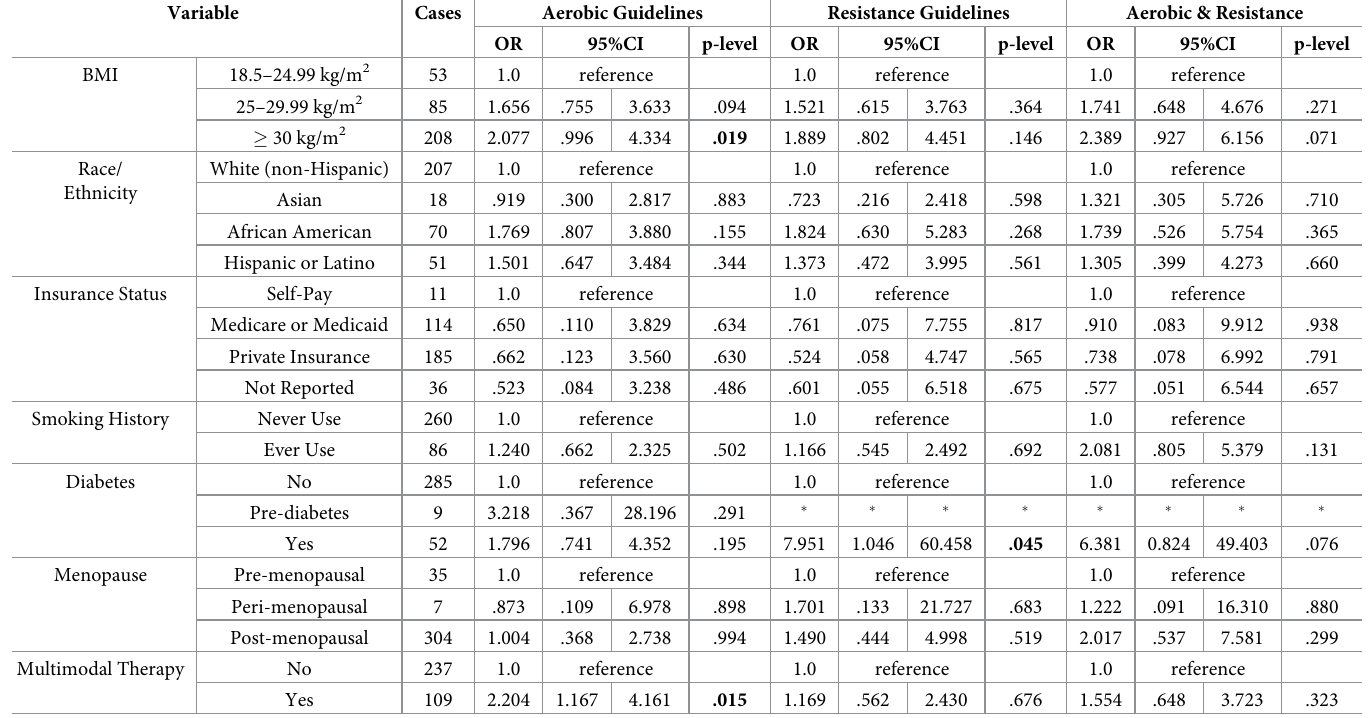
Table 3. Factors associated with non-adherence to activity guideline in female BC survivors (n = 346).